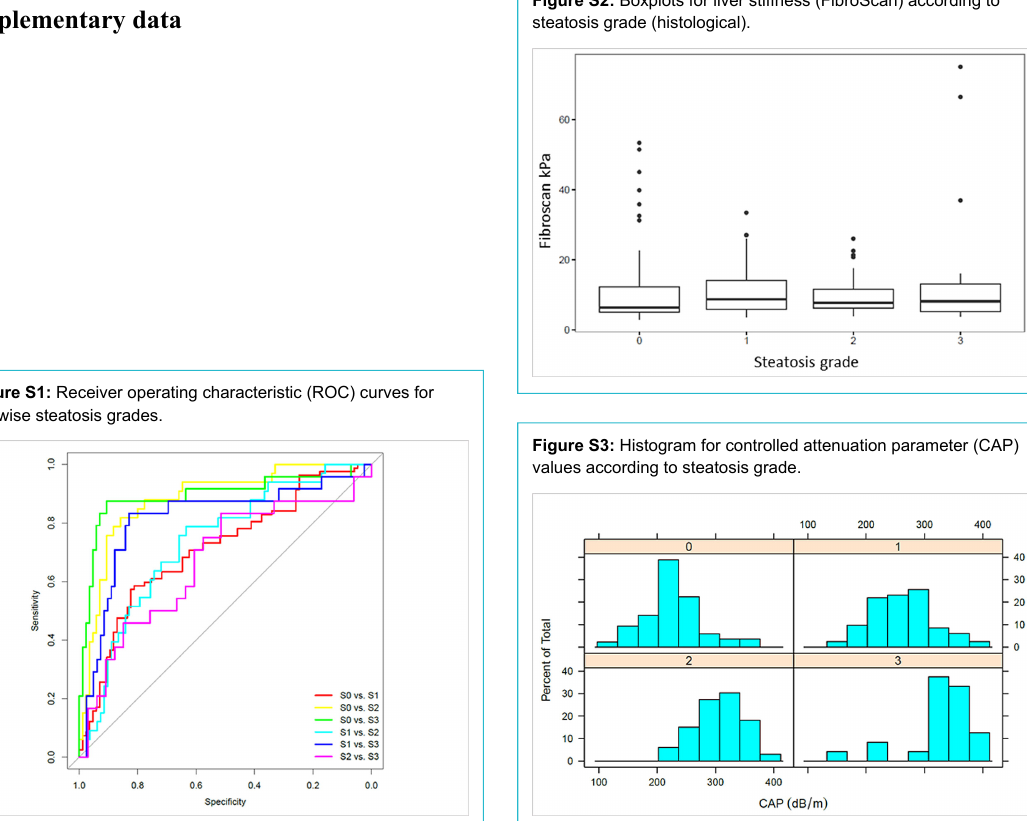
Figure S2: Boxplots for liver stiffness (FibroScan) according to steatosis grade (histological).